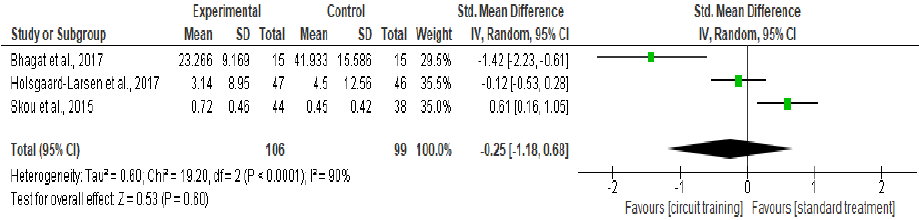
Figure 5. Forest plot analysis of the effect of CT on Quality of life [38,41,43].